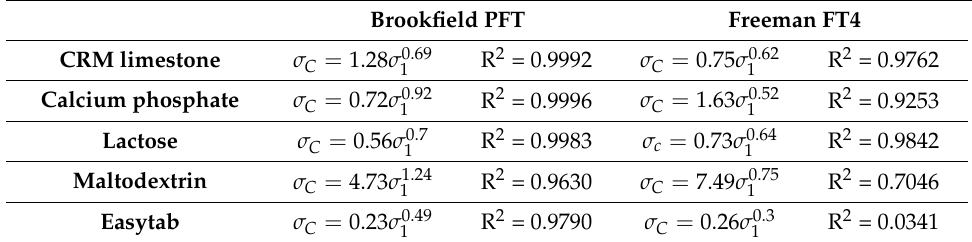
Table 2. Comparison of the flow functions obtained by the PFT and FT4 for the test materials.